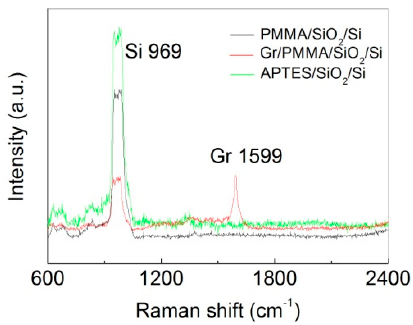
Figure 3. Raman spectra of poly-methylmethacrylate (PMMA) (black), graphene (red), and APTES (green), respectively. PMMA was spin-coated on SiO 2 /Si substrate (PMMA/SiO 2 /Si). Graphene (Gr) with PMMA was transferred onto the SiO 2 /Si substrate (Gr/PMMA/SiO 2 /Si). APTES was covalently attached onto the SiO 2 /Si substrate (APTES/SiO 2 /Si). The Raman integration time is ca. 2~5 min. PMMA, graphene, and APTES showed no fluorescence. Note that compared to Figure 2, the Raman peaks of Si and graphene are visible in this case due to the absence of fluorescence background and hence much reduced shot noise. The Raman peaks of PMMA and APTES were not observed due to their low Raman cross section.